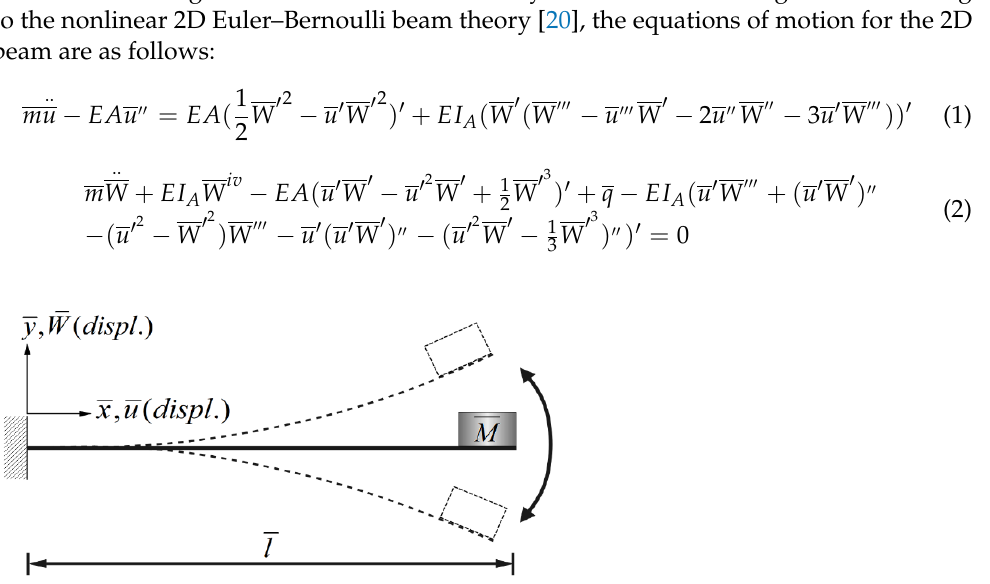
Figure 3. Coordinate of the fixed-free beam with tip mass.